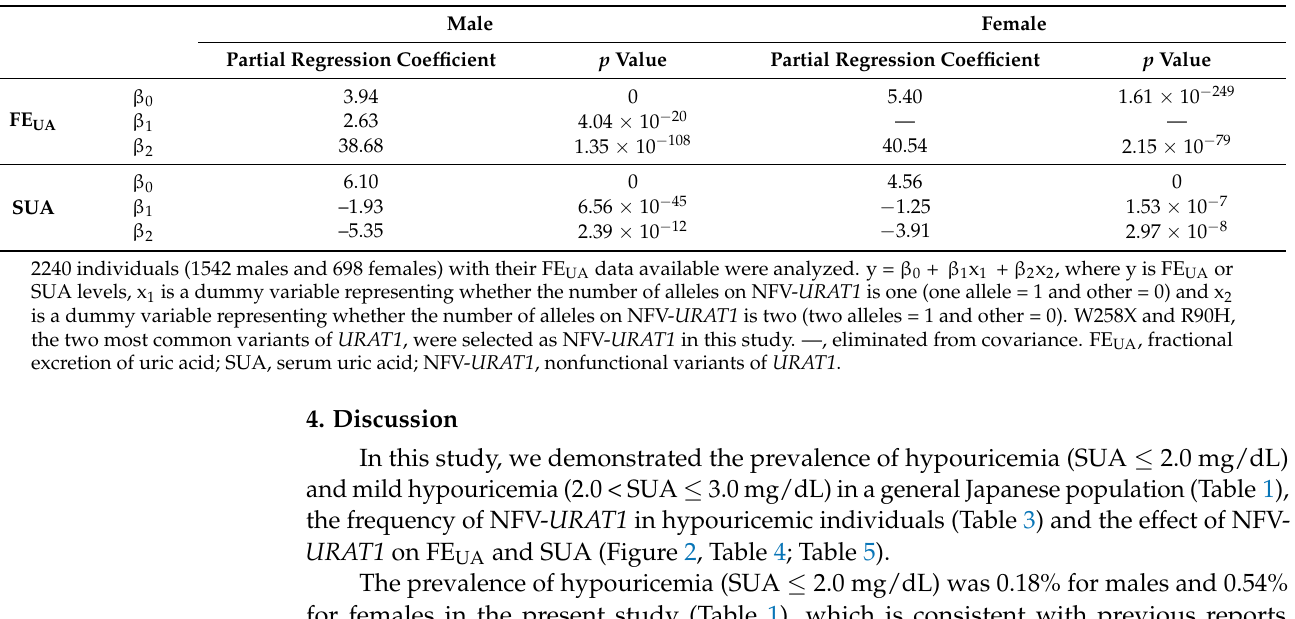
Table 5. Multiple regression analysis of FE UA and SUA along the number of NFV- URAT1